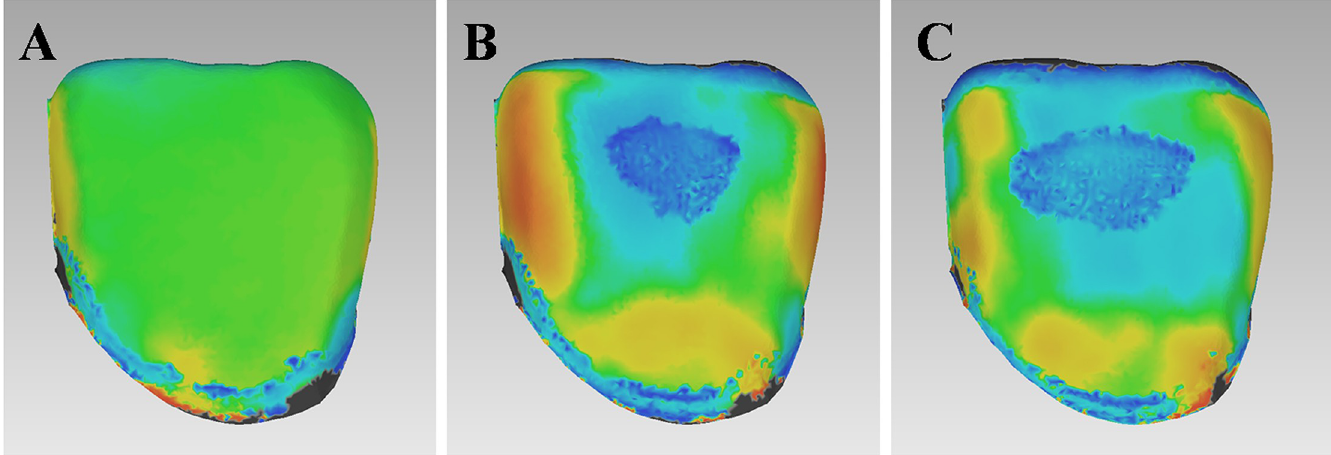
Fig 4. 3D color maps for comparing the auto-generated crown and original tooth using “optimal fitting alignment” and “3D analysis”. (A. BC mode, B. BI mode, C. BR mode).